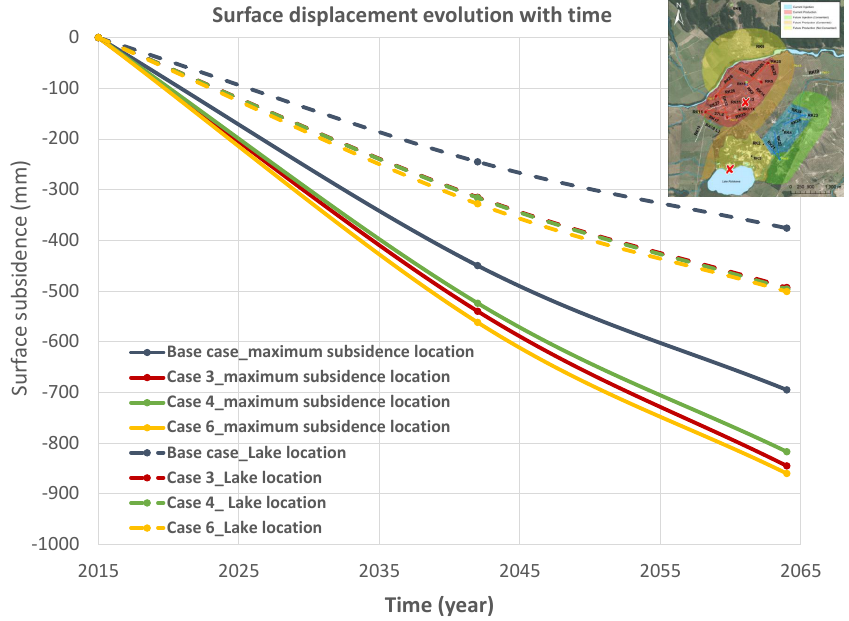
Figure 8. Surface displacement evolution with time at lake location and maximum subsidence location (see red marks in overview map) for all